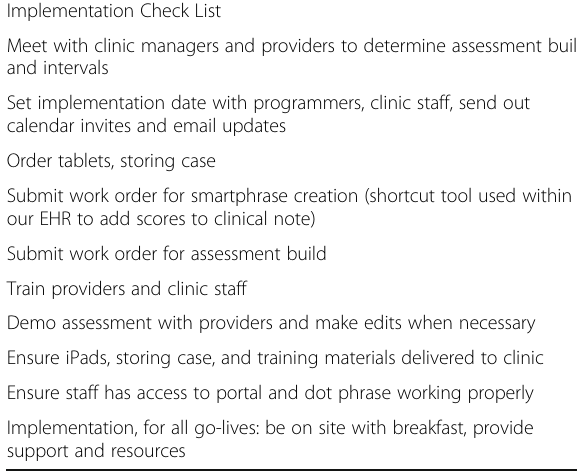
Implementation Check